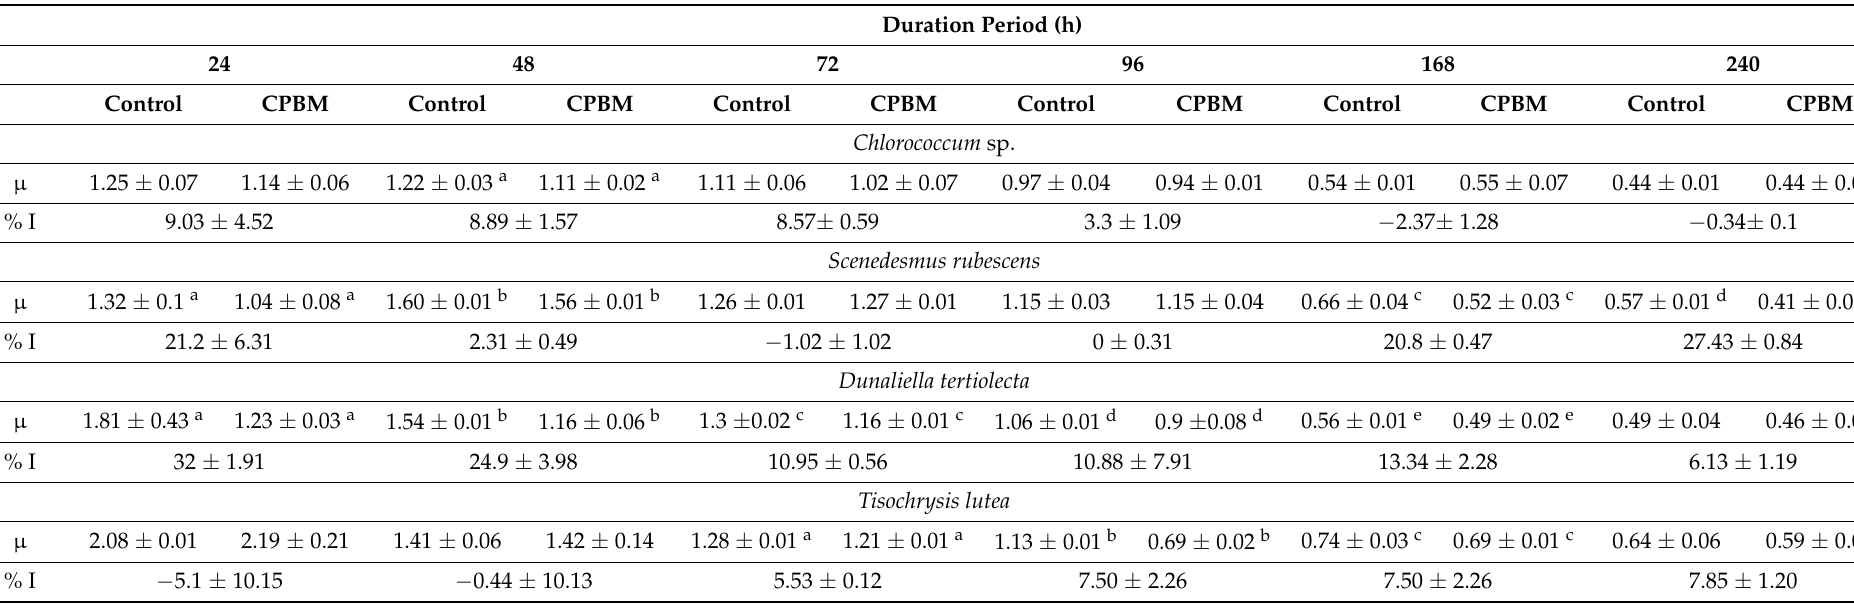
Table 2. Effects of PCMB leachate in freshwater algal species ( A ) Chlorococcum sp., ( B ) Scenedesmus rubescens , ( C ) Dunaliella tertiolecta and ( D ) Tisochrysis lutea . The results, in terms of